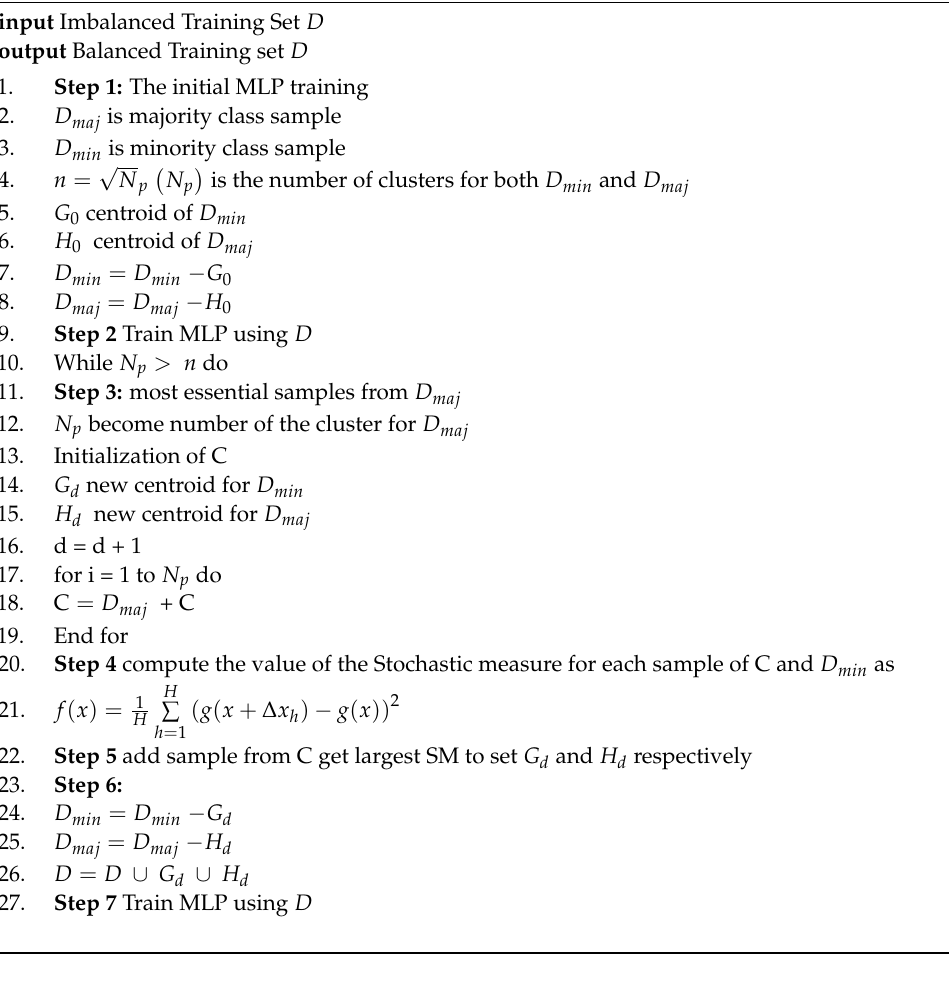
Algorithm 1 MultiLayer Perceptron UnderSampling (MLPUS)